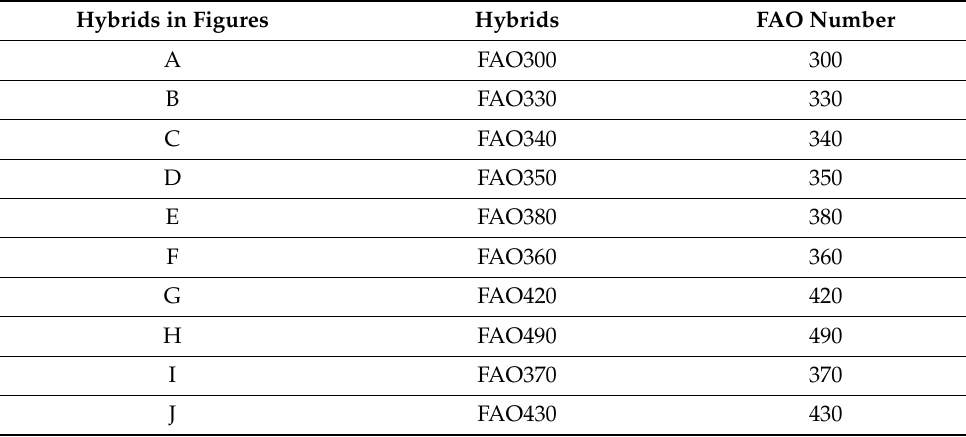
Table 2. Hybrids used in this